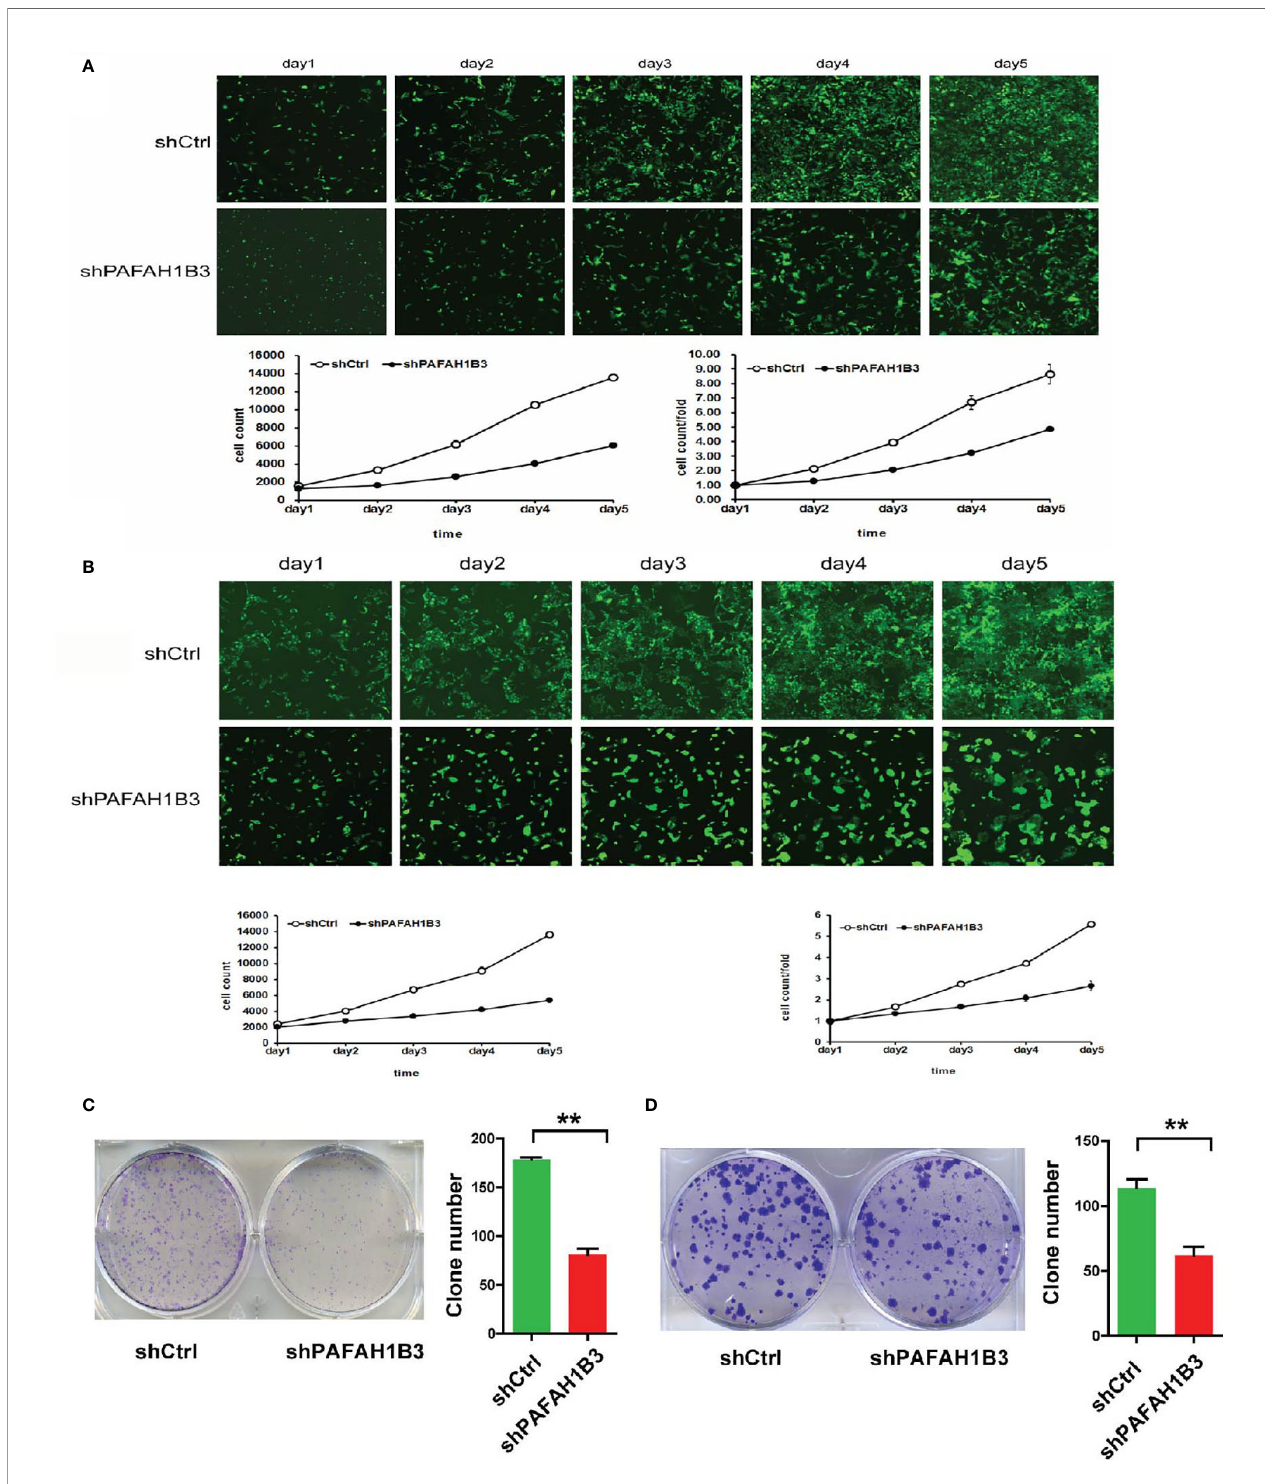
FIGURE 3 | PAFAH1B3 knockdown suppressed osteosarcoma cell proliferation. (A) Proliferation of MNNG/HOS cells was signi fi cantly inhibited in the absence of PAFAH1B3. (B) Proliferation of U-2 O cells was signi fi cantly inhibited in the absence of PAFAH1B3. (C) The ability of forming colonies of PAFAH1B3 knockdown cells was signi fi cantly restrained compared with control cells in MNNG/HOS cell line. Data were expressed as the mean ± s.d., ** P < 0.01. (D) The ability of forming colonies of PAFAH1B3 knockdown cells was signi fi cantly restrained compared with control cells in U-2 OS cell line. Data were expressed as the mean ± s.d., ** P <